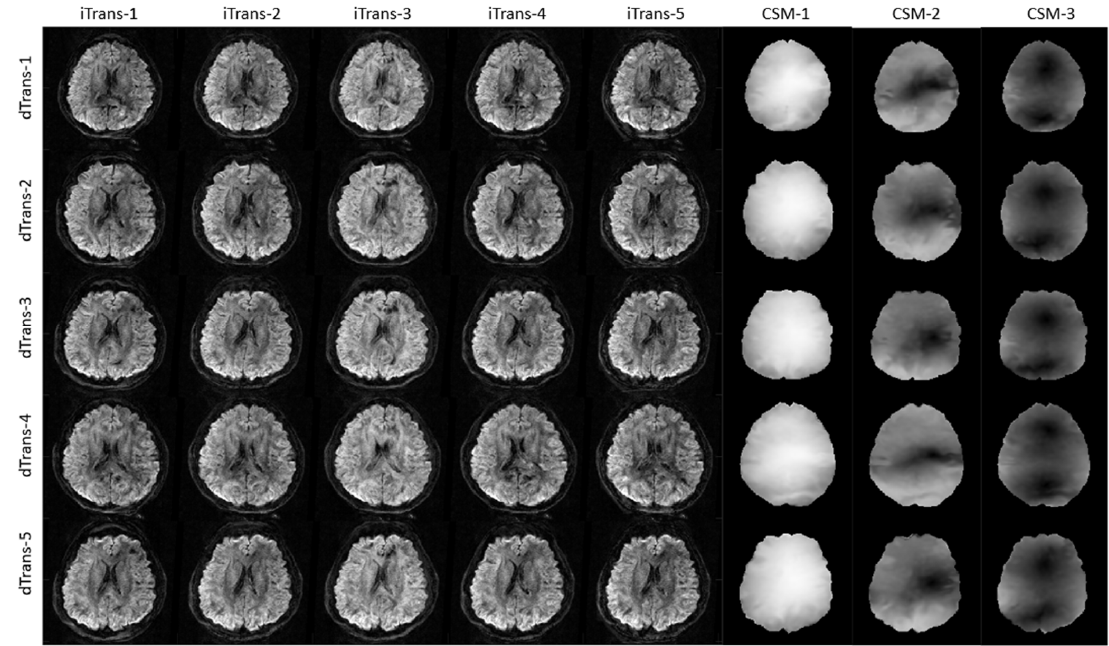
Figure 2. Cross-augmented high resolution DWIs with b = 1000 s/mm 2 and the corresponding CSMs. The iTrans-N represents the intensity transformation from the Nth target. dTrans-N refers to the displacement from the Nth target.